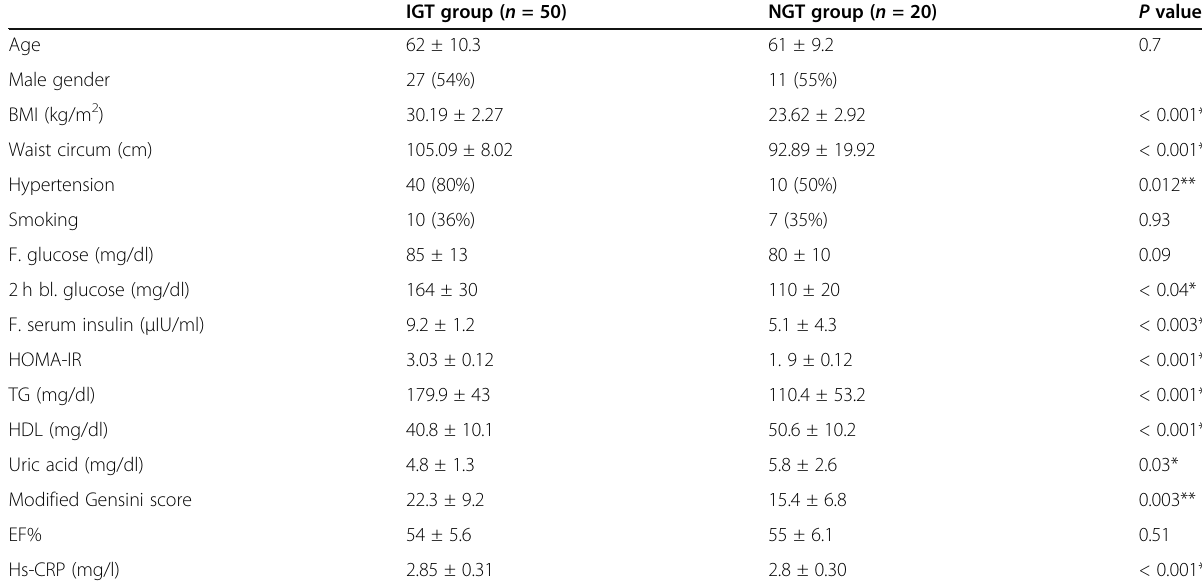
Table 1 Clinical, metabolic, and angiographic variables